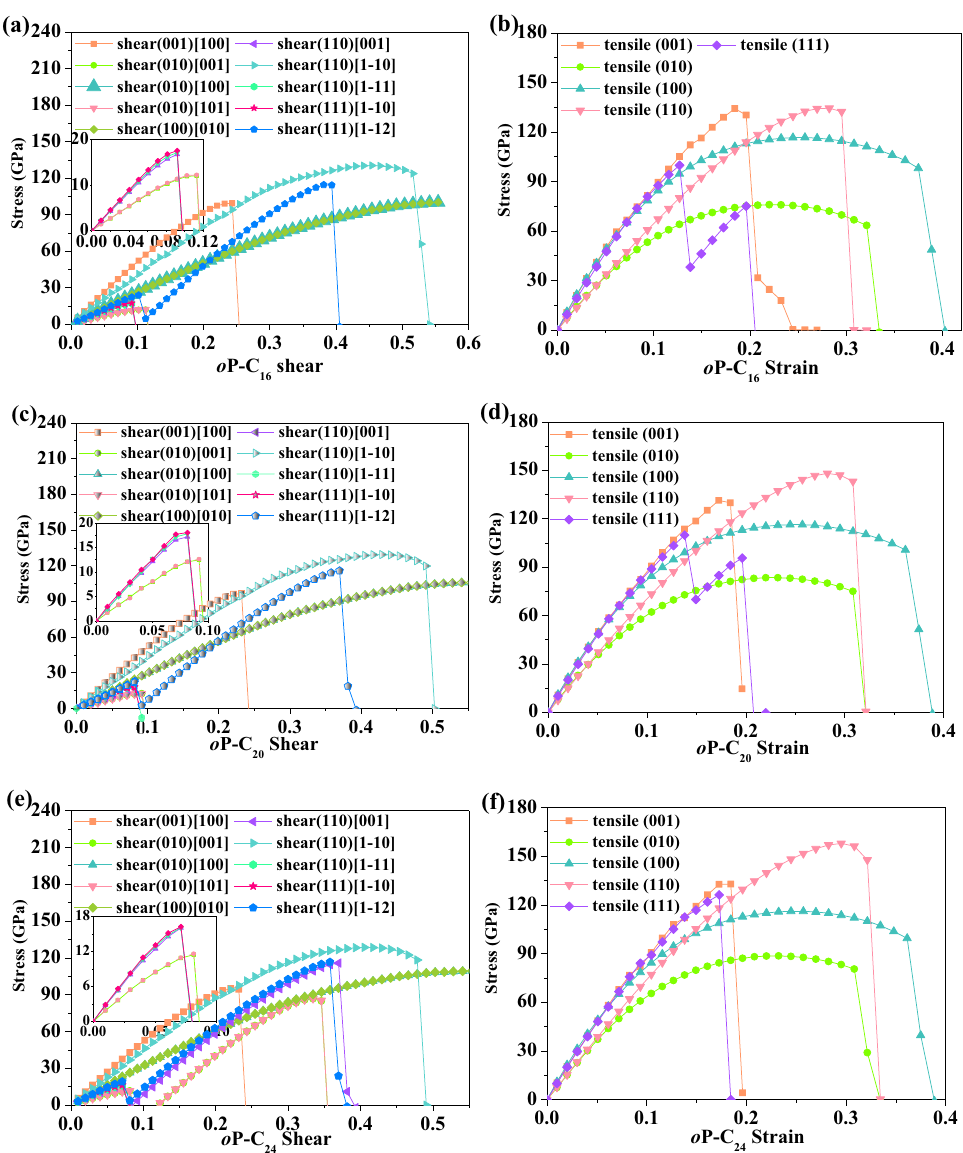
Figure 2: Calculated stress vs shear strain and the stress versus tensile strain for o P - C 16 ( a and b ) , o P - C 20 ( c and d ) , and o P - C 24 ( e and f ) in principal symmetry